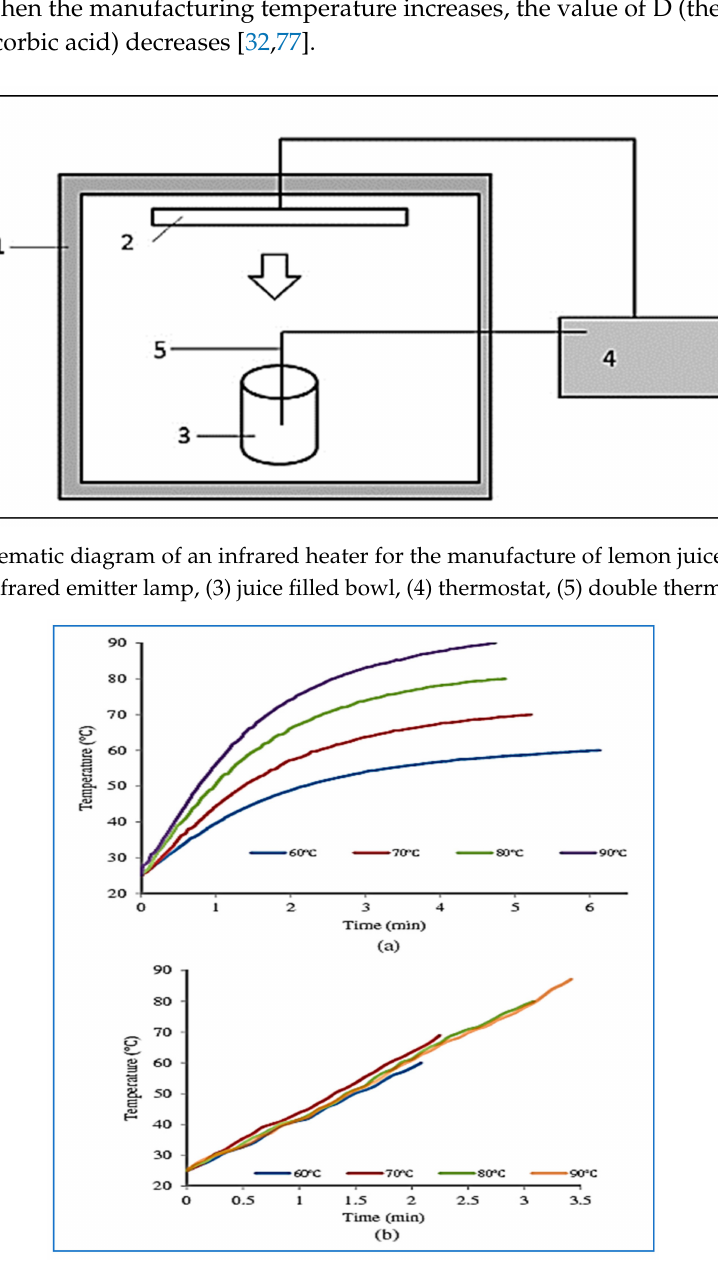
Figure 12. Juice temperatures change over time ( a ) conventional heating, ( b ) infrared heating